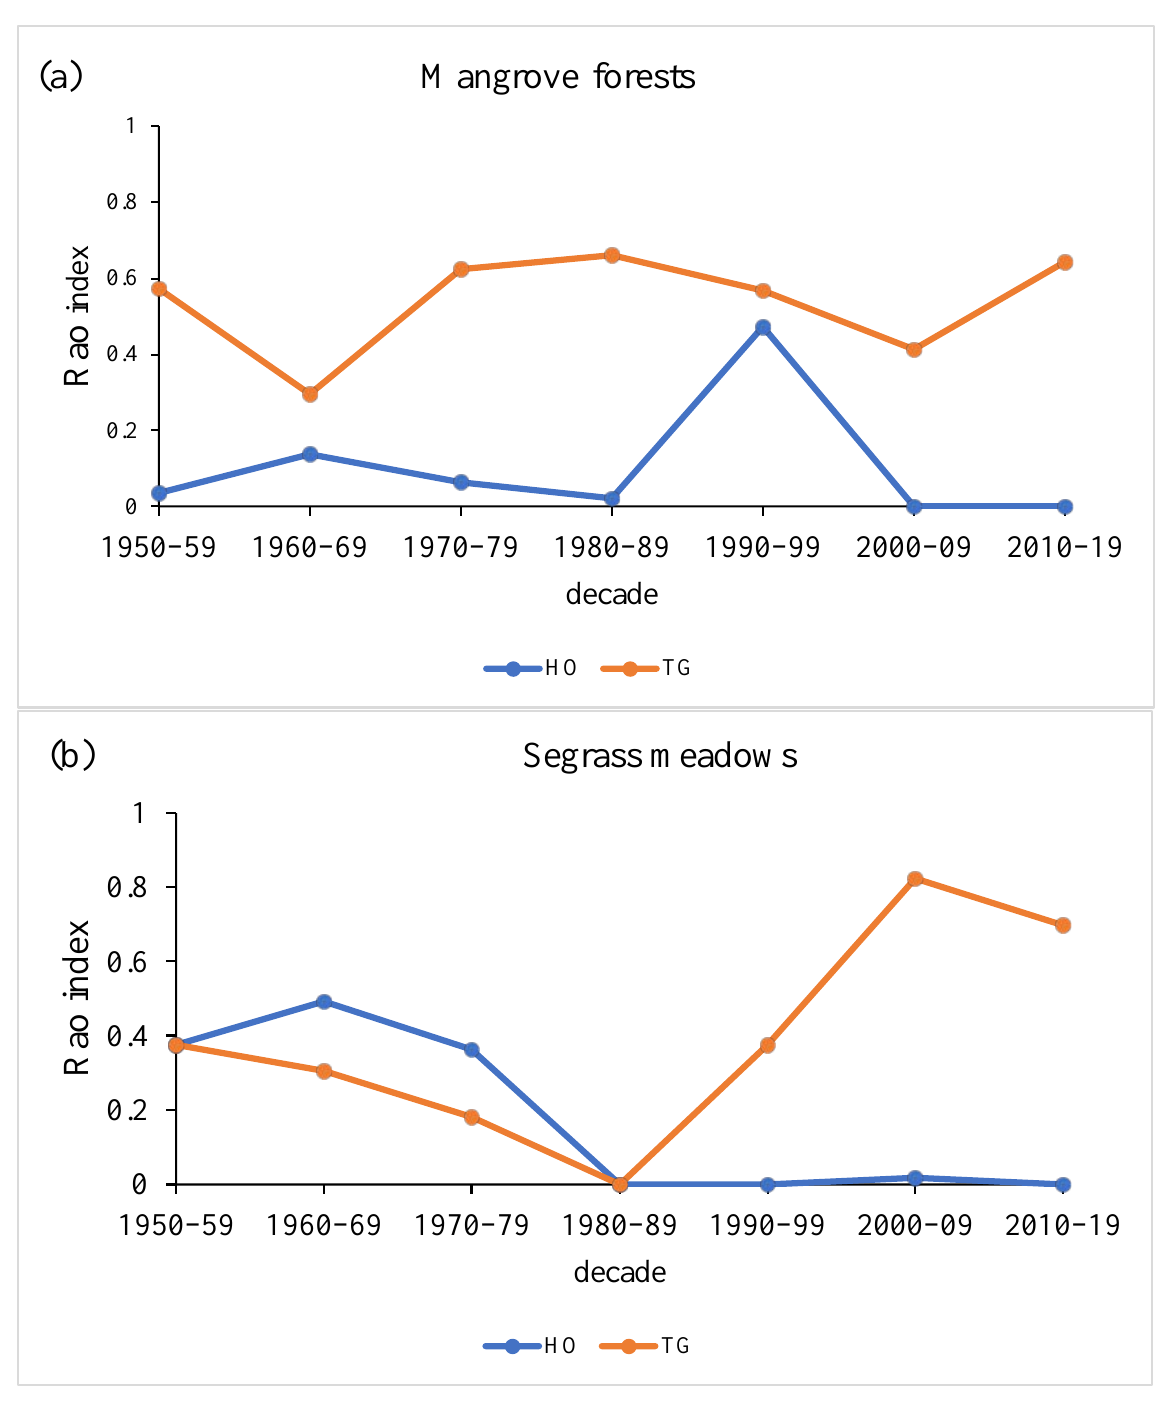
Figure 4. Marine invertebrate functional diversity (Rao Index) based on habitat occupation (HO) and trophic guild (TG) traits per decade in Maputo Bay. ( a ) Mangroves; ( b ) seagrasses.